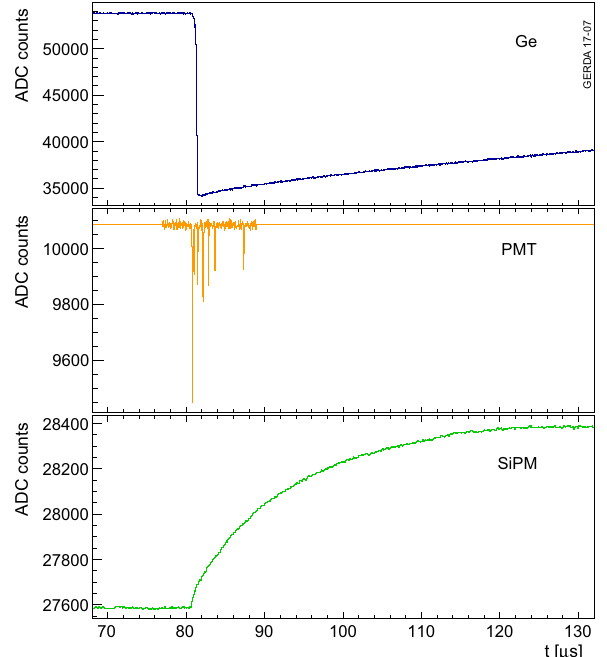
Fig. 18 Sample traces of an event with signals in a Ge detector and the LAr veto system. On top the trace of the Ge detector that triggered the event;aPMTtraceinthemiddle–thefastcomponentofthescintillation light is followed by several smaller pulses from the triplet component; at bottom one of the SiPMs traces with the expected slower signal (see Sect. 3.2)